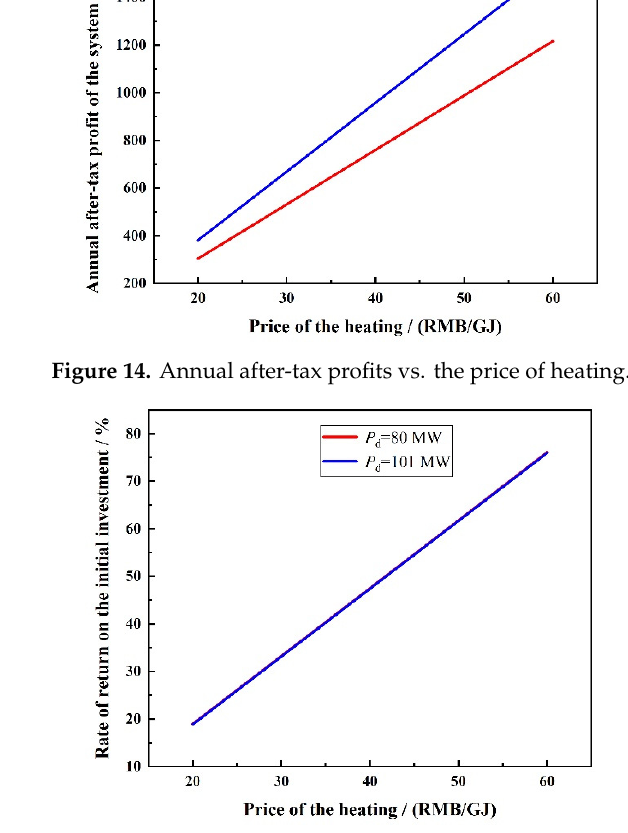
Figure 15. Rate of return on the initial investment vs. the price of heating.